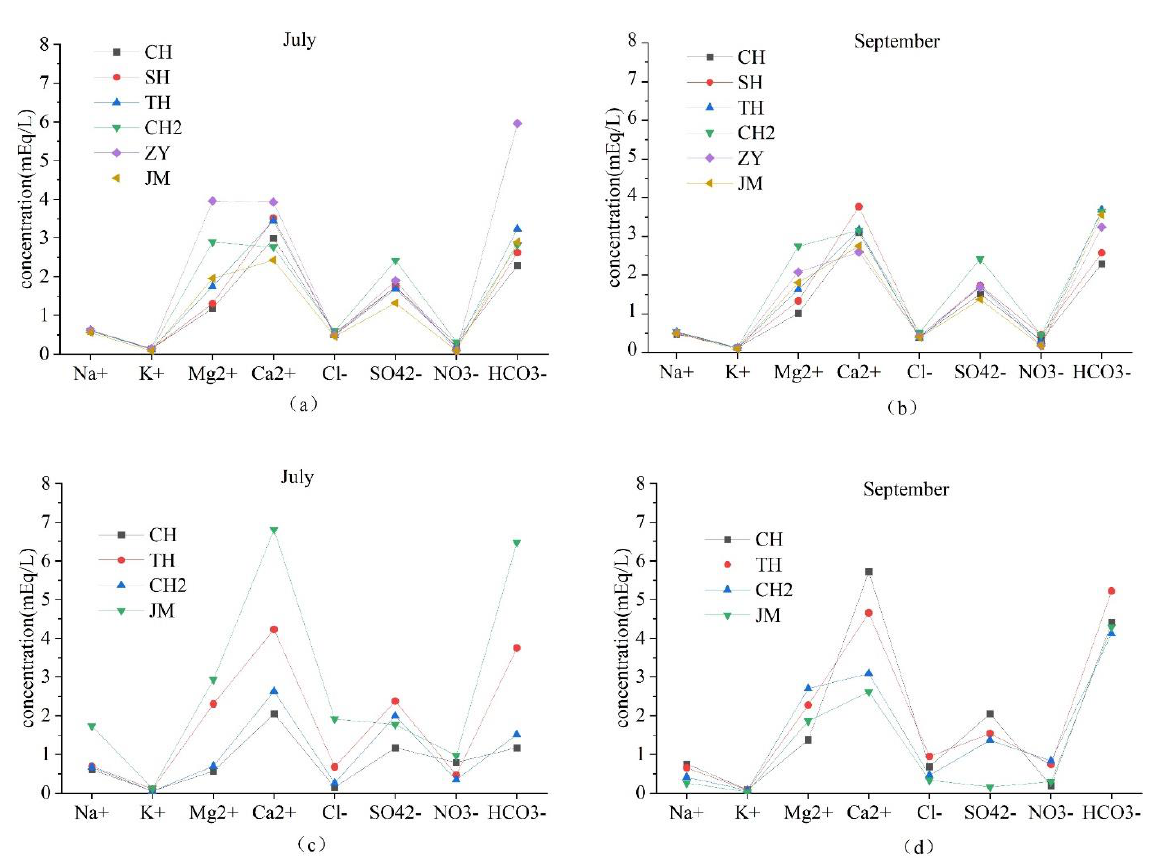
Figure 2. Average concentration of anions and cations in the surface and groundwater sampled in September 2018 and July 2019 in the mountainous watershed of Daqing River. ( a ) The average concentration of anions and cations in surface water in July; ( b ) the average concentration of anions and cations in surface water in September; ( c ) the average concentration of anions and cations in groundwater in July; ( d ) the average concentration of anions and cations in groundwater in September (CH—Ci river, SH—Sha river, TH—Tang river, CH2—Cao river, ZY—Zhongyi river, JM—Juma river).